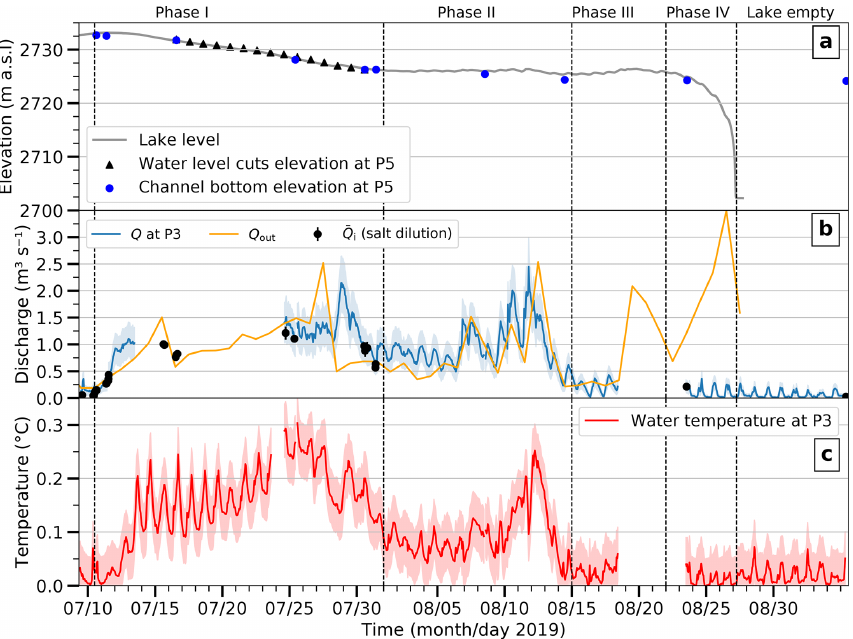
Figure 6. (a) Lake-level elevation (continuous curve), channel bottom elevation (blue dots) and water level cut elevations (black dots) at P5. (b) Hourly channel discharge at P3 ( Q ), direct discharge measurement by salt dilution averaged over all stations ( Q i ) and lake discharge from elevation change ( Q out ). (c) Water temperature at P3. The four distinct lake drainage phases are delimited by the dashed line and explained in the main text (Sect. 4.1). Standard uncertainties for hourly discharge and temperature are shown with light bands.